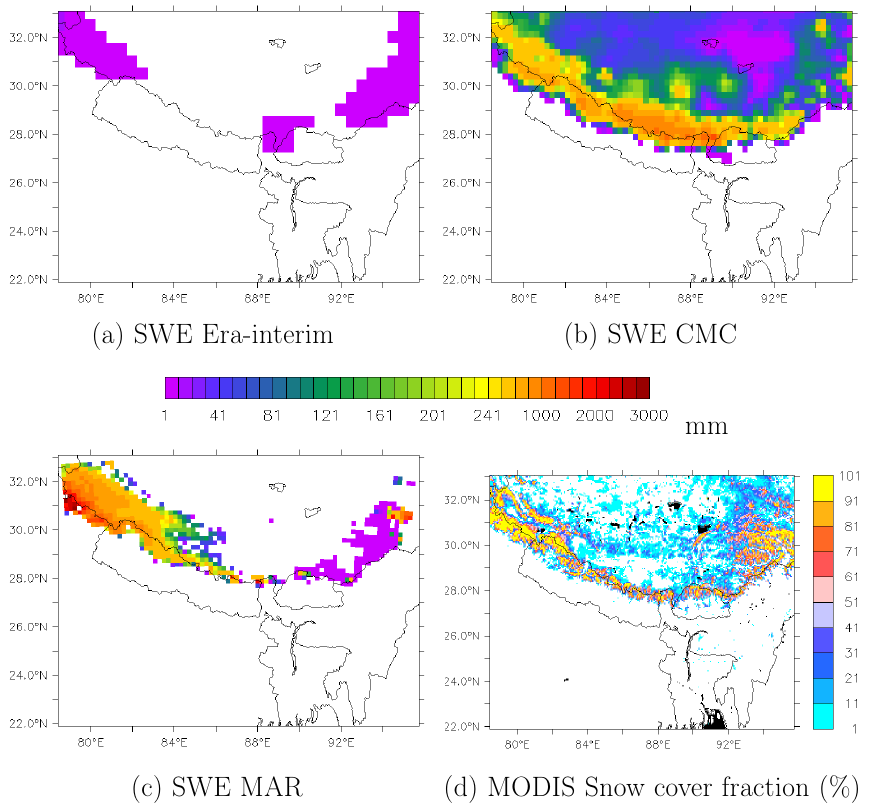
Fig. 5. April 2001 Snow Water Equivalent (mm): (a) estimated from the ERA-INTERIM, (b) evaluated by the Canadian Meteorological Centre (CMC) and (c) simulated with MAR. (d) shows the Snow Cover Extent (SCE) observed with MODIS for the same